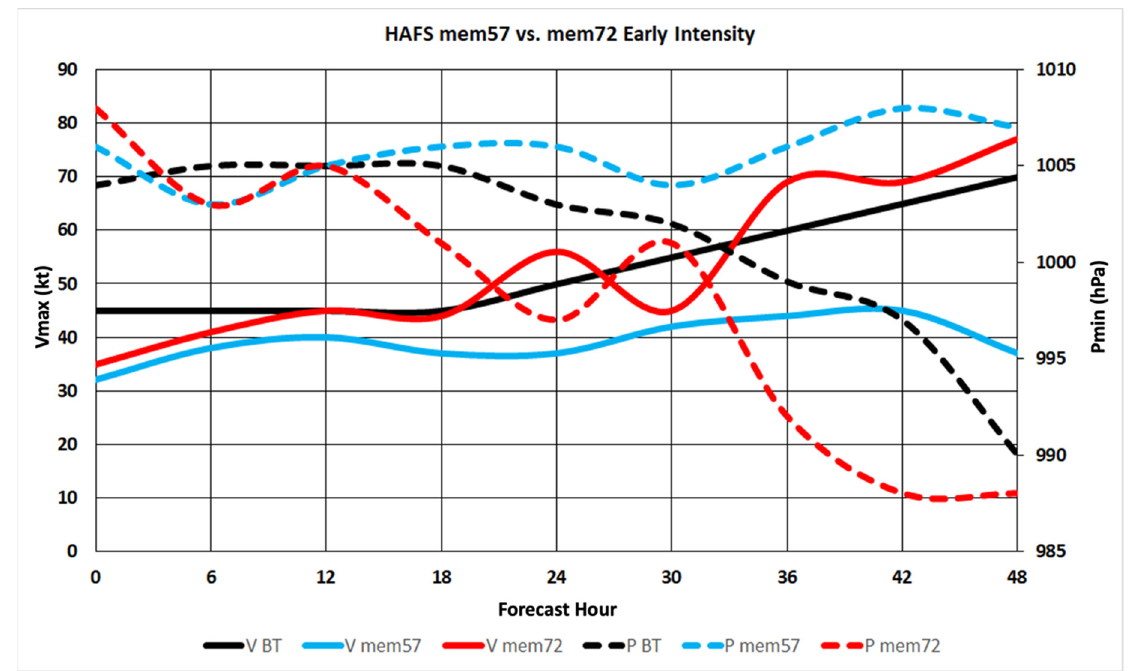
Figure 10. Maximum sustained wind speed (kt, 1 kt = 0.51 m s − 1 ) in the solid lines and minimum central pressure (hPa) in the dashed lines for the weak member (blue), the strong member (red), and Best Track for Dorian (black) from 0 to 48 h of the simulation. The time series are smoothed for plotting.